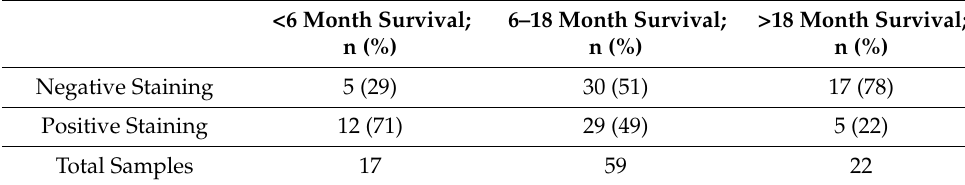
#20-IL-11R α and #28-IL-11R α (Figure